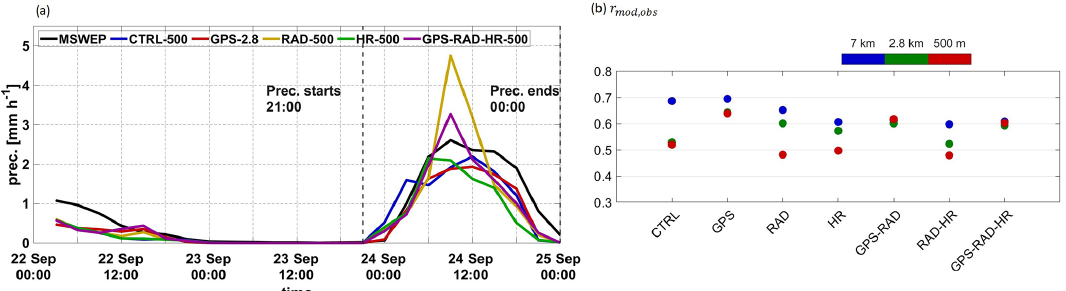
Figure 6. Temporal evolution of spatially averaged precipitation (a) and temporal correlation validation of the precipitation temporal evolu- tion (b) . All simulations have been coarse-grained to the MSWEP spatial resolution (0.1 ◦ ). Spatial averages are performed for 3-hourly data. The corresponding results of (a) for the 7 and 2.8km simulations can be found in Figs. S3a and S4a of the Supplement.